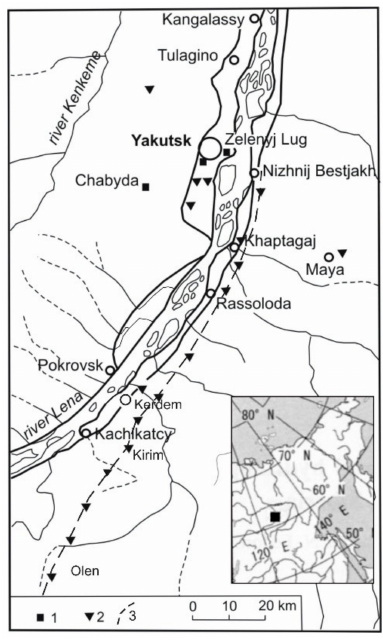
Figure 1. Scheme of the work area: 1—stations; 2—polygons; 3—roads and